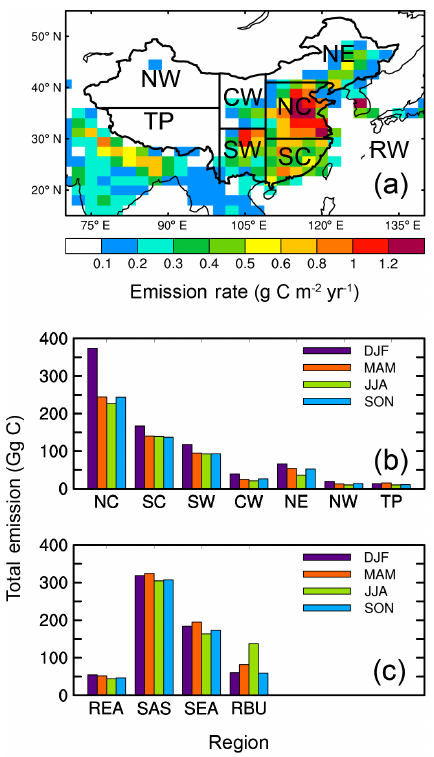
Figure 1. (a) Spatial distribution of annual mean total emissions (anthropogenic plus biomass burning in units of gCm − 2 yr − 1 ) of black carbon (BC) averaged over 2010–2014. The geographical BC source regions are selected as north China (NC; 109 ◦ E–east bor- der, 30–41 ◦ N), south China (SC; 109 ◦ E–east border, south border– 30 ◦ N), southwest China (SW; 100–109 ◦ N, south border–32 ◦ N), central–west China (CW; 100,–109 ◦ N, 32 ◦ N–north border), north- east China (NE; 109 ◦ E–east border, 41 ◦ N–north border), north- west China (NW; west border–100 ◦ E, 36 ◦ N–north border) and the Tibetan Plateau (TP; west border–100 ◦ E, south border–36 ◦ N) in China and regions outside of China (RW; rest of the world). (b) Sea- sonal mean total emissions (units: Gg C; Gg: 10 9 g) of BC from the seven BC source regions in China and emissions from the rest of East Asia (REA, with China excluded), South Asia (SAS), South- east Asia (SEA) and Russia–Belarussia–Ukraine